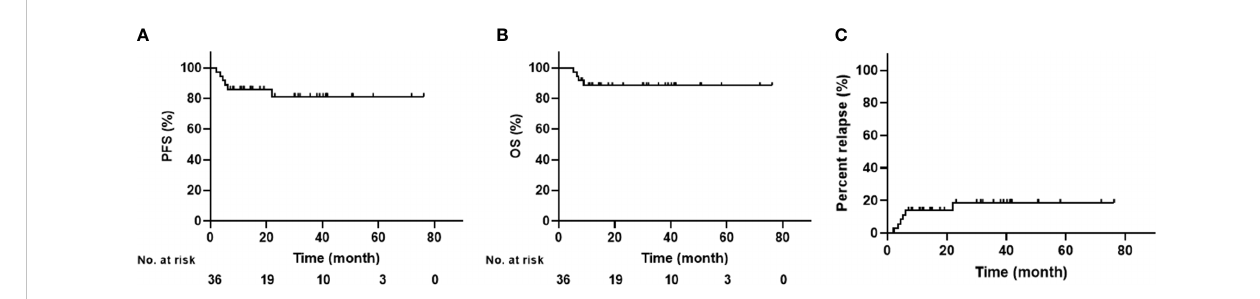
FIGURE 2 Survival Curve of All Included Patients (A) PFS; (B) OS; (C) Percentage of relapse).